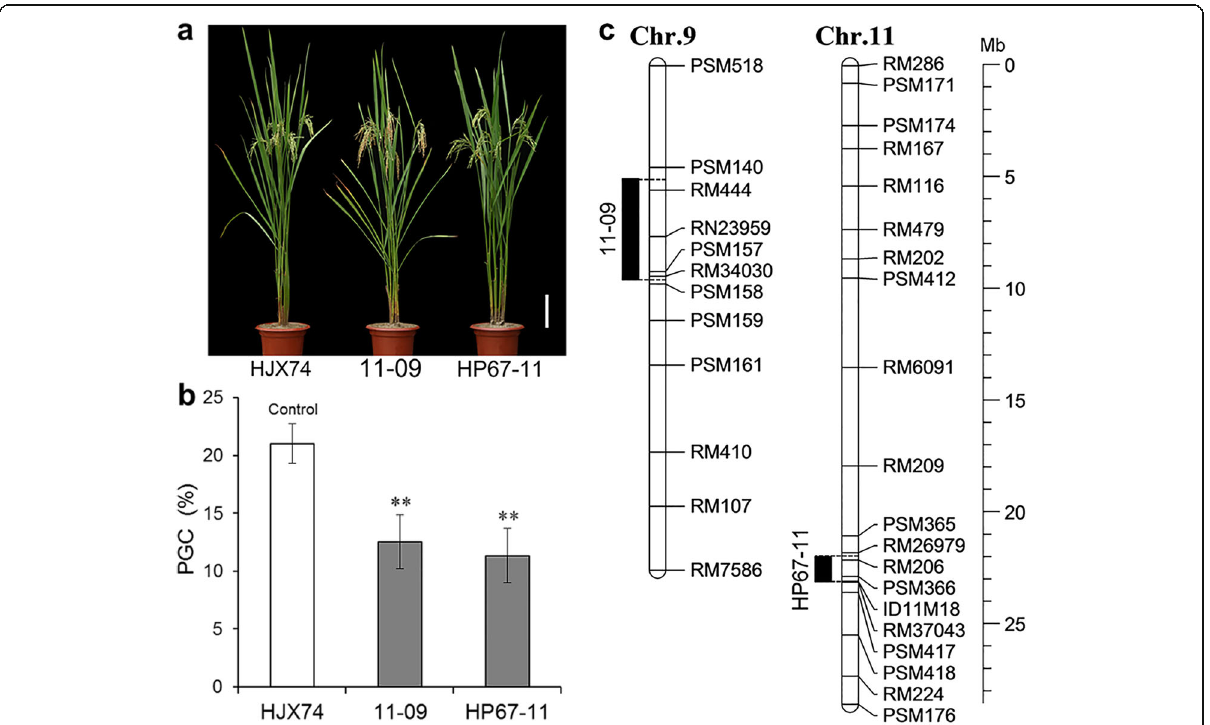
Fig. 1 Grain chalkiness in HJX74 and SSSLs. a , Plant type of HJX74 and SSSLs 11 – 09 and HP67 – 11. Scale bar: 15 cm. b , Percentage of grain chalkiness (PGC) (%) in HJX74 and SSSLs. Data were presented as mean ± S.E. of eight cropping seasons. One-way ANOVA, two-tailed, Dunnett t - test was used to generate the differences. c, Chromosome locations of the two SSSLs. Physical distance (Mb) is shown as rulers on the right of chromosome. Black bars on the left of each chromosome represent the estimated length of substitution segments in the SSSLs. Chr. chromosome, Mb